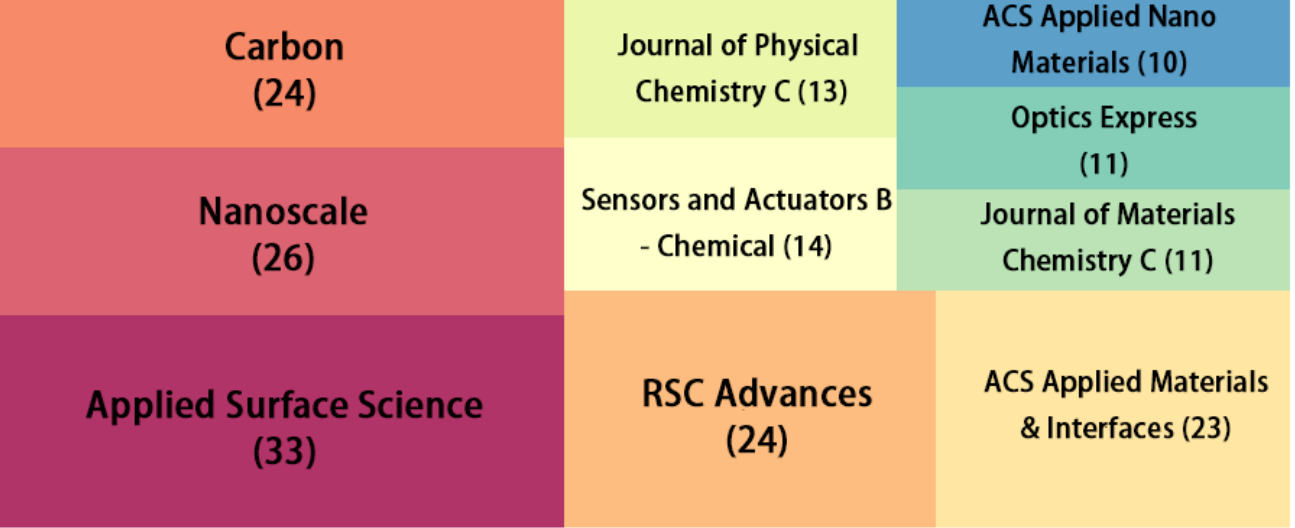
Figure 2. The top 10 journals that published articles on the graphene ‐ based SERS.